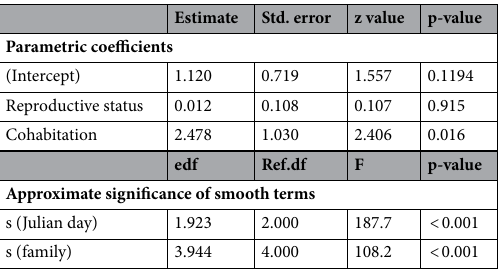
Table 2. Effect of predictor variables (reproductive status, cohabitation, Julian day, and family ID) estimated by the Generalised Additive Model (with a binomial error distribution) fitted to predict the inhabitation of the settlements (main vs secondary) by crested porcupine in Central Italy. Coefficients (Estimate) for the linear terms in the model (reproductive status, cohabitation), standard errors (Std. Error), test statistic and its significance (z value and p-value) are shown in the first part of the Table. Effective degrees of freedom (edf, representing the complexity of the smooth terms), together with test statistic (F), its significance (p-value) and degree of freedom (Ref.df) used to assess overall significance of the smooth terms, are shown in the second section.